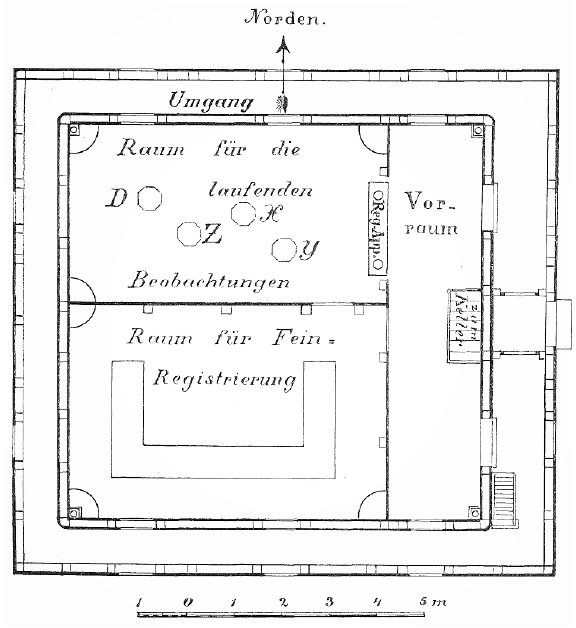
Figure 2. Seddin Observatory service house. Source: Helmholtz Centre Potsdam – GFZ.